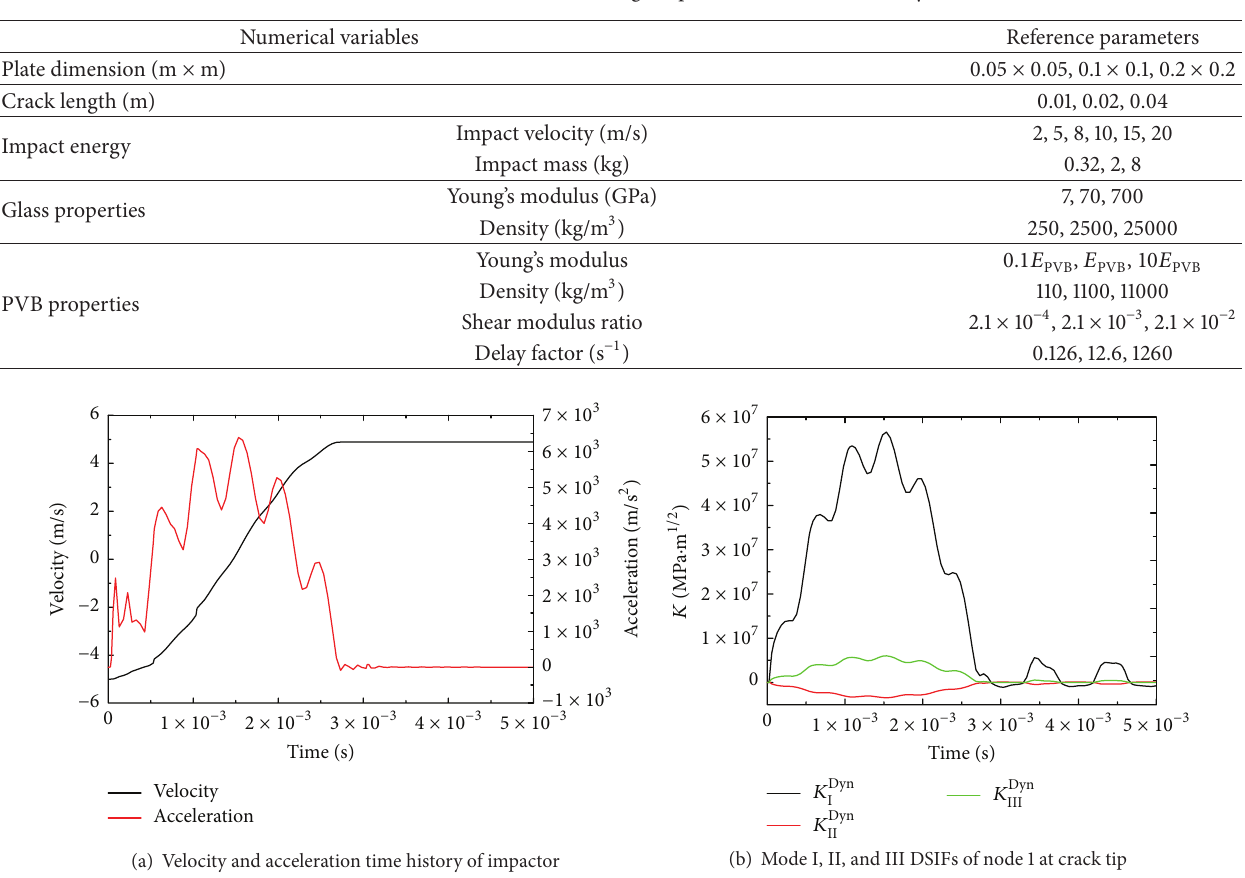
Table 2: The detailed variable settings in parametric numerical study.